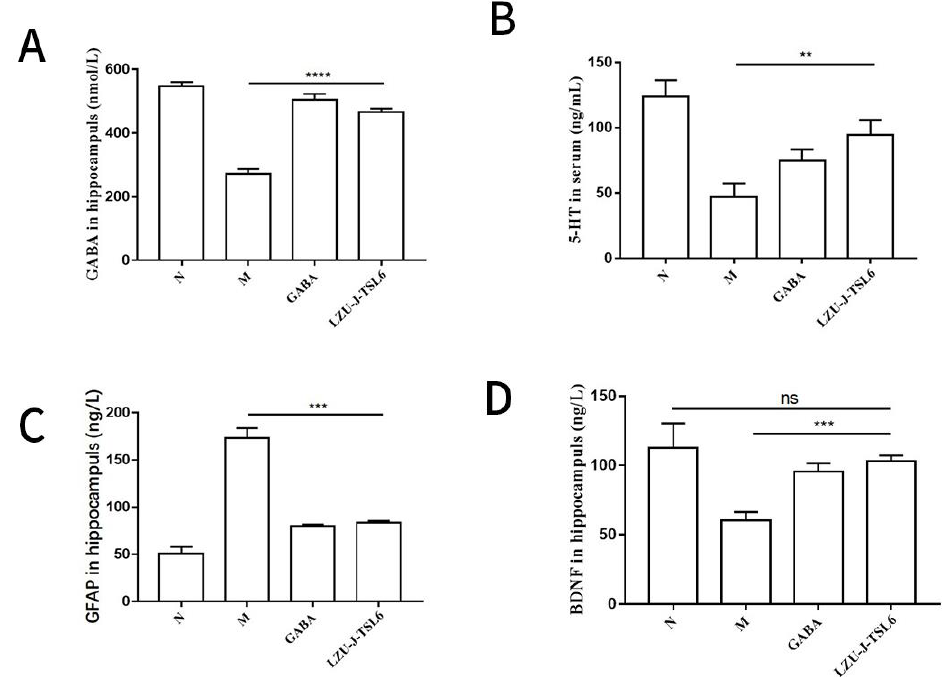
Figure 3. Effect of LZU-J-TSL6 on the hippocampus and serum markers in mice with anxiety disorder: Changes in the levels of markers in the hippocampus of mice (GABA, BDNF, and GFAP) ( A – C ). Changes of 5-HT content in the serum of mice ( D ). Bars show the mean ± SD ( n = 5 mice per group) ** p < 0.01; *** p < 0.001; **** p < 0.0001. ns: there is no significant difference between the two